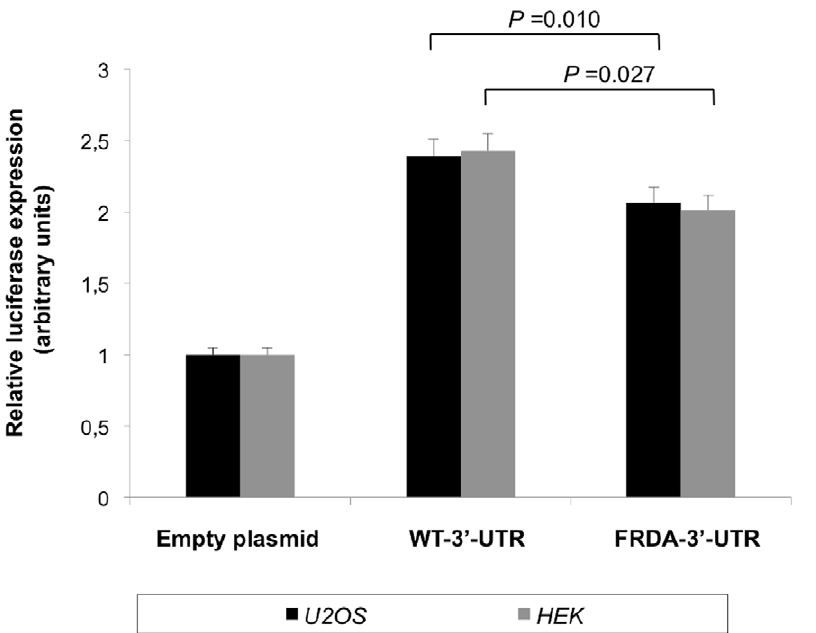
Figure 3. Functional assessment of FRDA-3 9 -UTR versus WT-3 9 -UTR. U2OS (black bars) and HEK-293 (grey bars) cells were transfected with luciferase reporter gene system, respectively 150 ng of empty plasmid or plasmid WT-3 9 -UTR or plasmid FRDA-3 9 -UTR. Histograms show the Renilla luciferase activity (normalized to firefly luciferase and to the mock transfected cells) following transfection of each plasmid into both cell lines. All results represent mean 6 SEM of three independent experiments, each in triplicate. * P , 0.05, Student-t